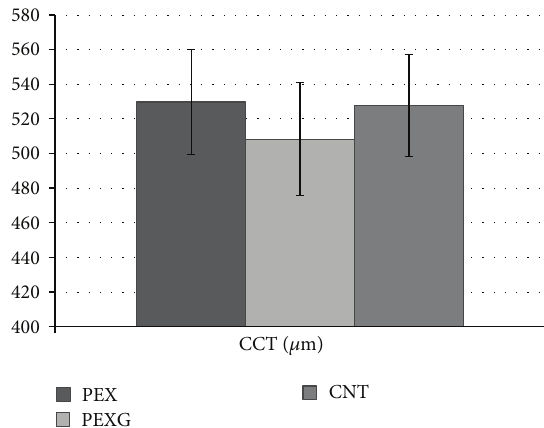
with PEX syndrome (PEX), PEX glaucoma (PEXG), and the control group (CNT).